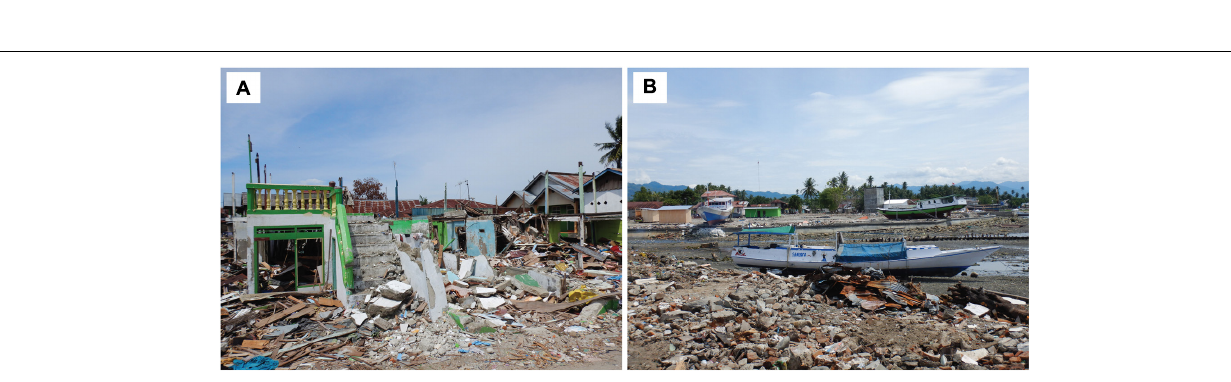
Frontiers in Earth Science |